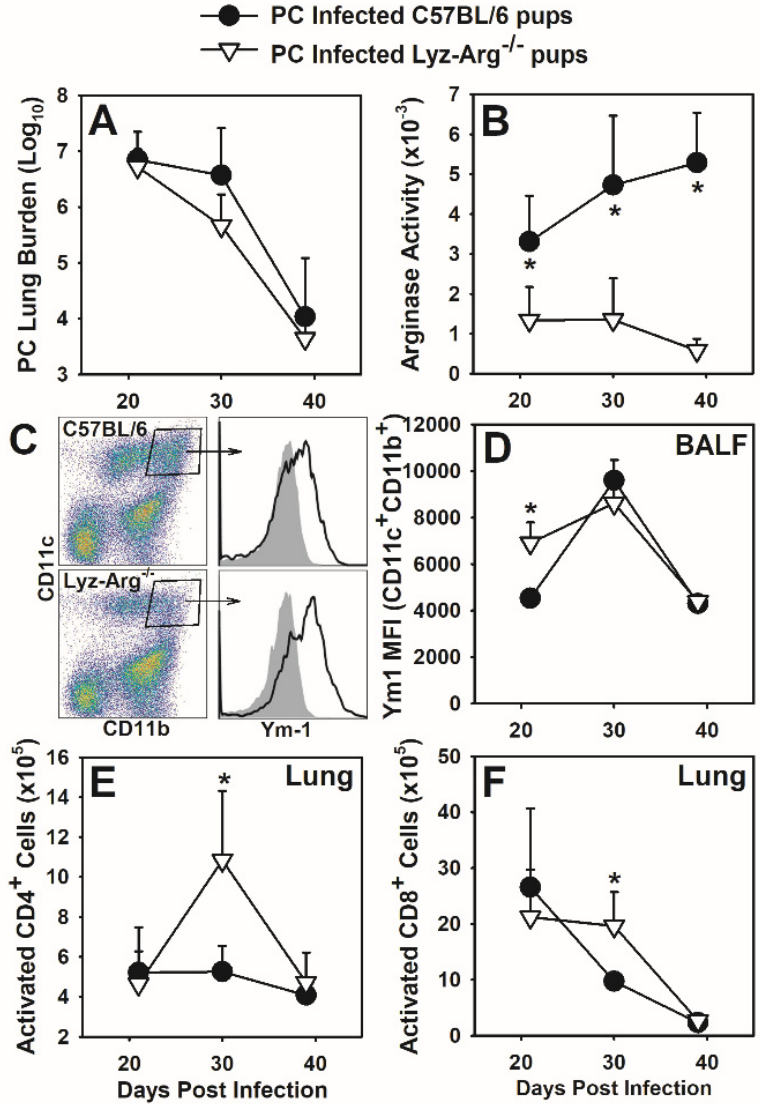
Figure 3. Lyz-Arg − / − neonates have similar immune responses to P. murina as wildtype neonates. Two-day-old Lyz-Arg − / − and C57BL/6 (wildtype) pups were infected with P. murina . At indicated days post infection, BALF and right lung lobes were collected from 4–6 mice per group. ( A ) P. murina lung burden was determined microscopically. ( B ) Lung digest lysates were used to determine arginase activity within the lung. ( C ) BALF cells obtained at day 21 post-infection were stained with antibody against CD11c, CD11b, and Ym1 and analyzed by flow cytometry. CD11c + CD11b + are considered to be activated AMs. CD11c + CD11b + cells (( C ), dot plots) were examined for Ym1 expression (( C ), histograms) and mean fluorescent intensity quantitated as shown in ( D ). ( E , F ) Lung digest cells were stained with antibodies against CD4, CD8, CD44 and CD62L. T cell populations expressing high CD44 and low CD62L were considered to be activated. Data represent the mean ± SD and are representative of 2 independent experiments. * p ≤ 0.05, comparing P. murina infected C57BL/6